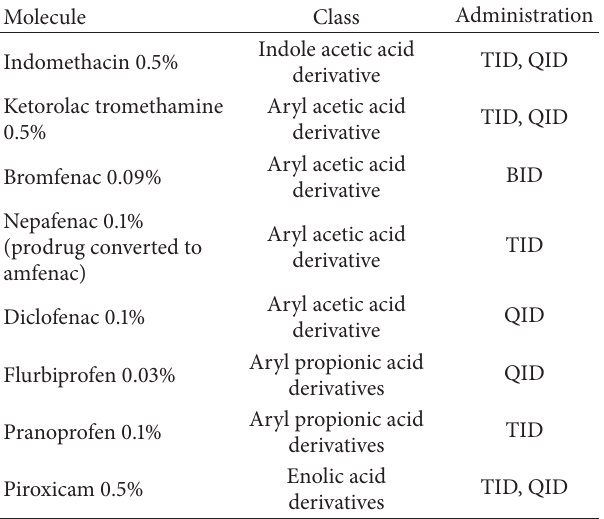
Table 1: Commercially available topical